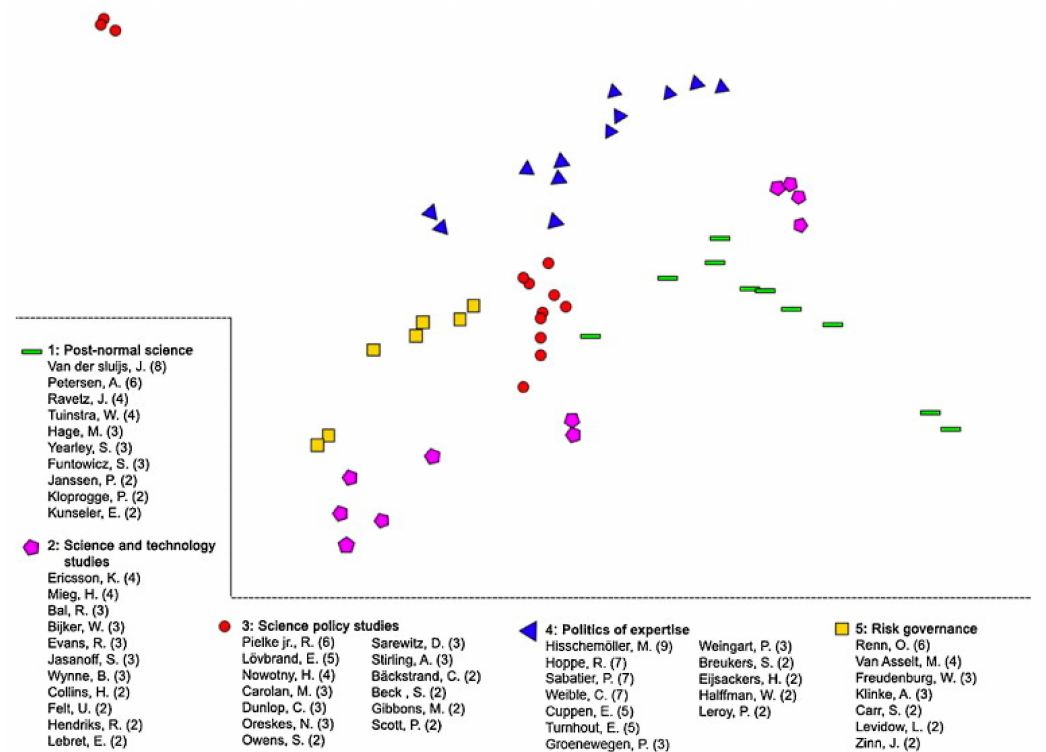
Figure 10. Co-citation analysis of reviewed literature on roles of scientists as policy advisors by different fields of science. (From [37]; reprinted by permission of